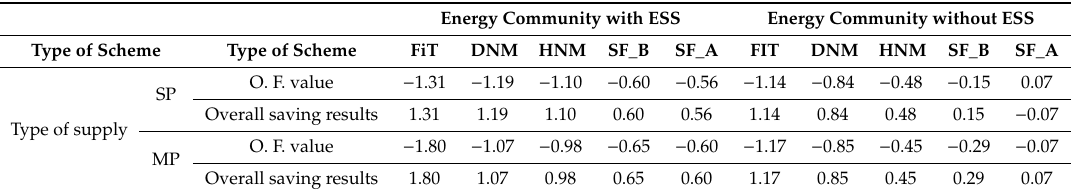
Figure 16. Energy management during the simulation day under all schemes without an ESS configuration. ( a ). Energy management during the simulation day under the type-A self-consumption scheme without ESS configurations. ( b ). Energy management during the simulation day under the rest of schemes without ESS configurations. Table 5. The Objective function and overall saving results [ € / day] for the energy community under di ff erent regulatory schemes